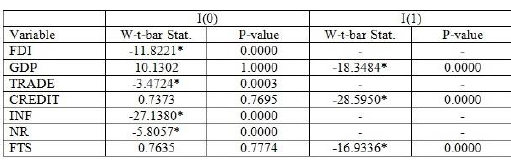
Table 4: IPS Unit Root Test Outcomes